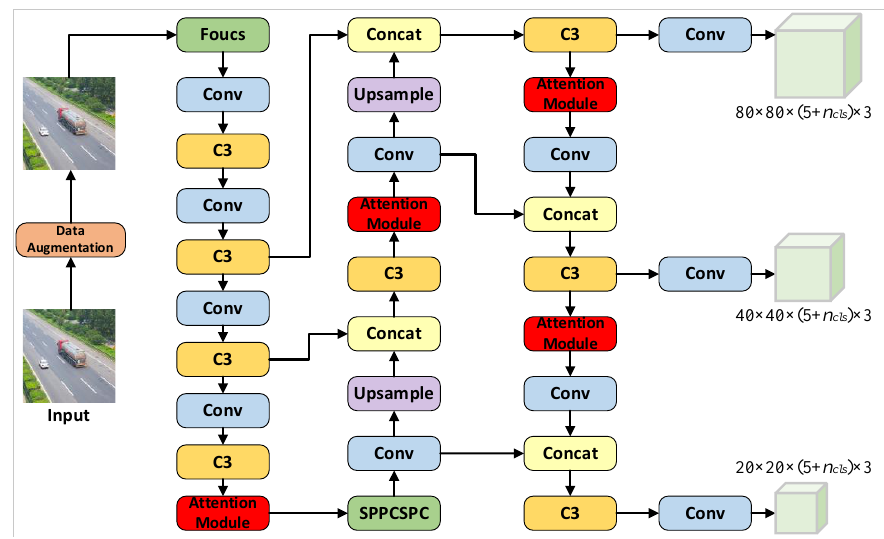
Figure 9. Illustration of the architecture of the designed vehicle detection